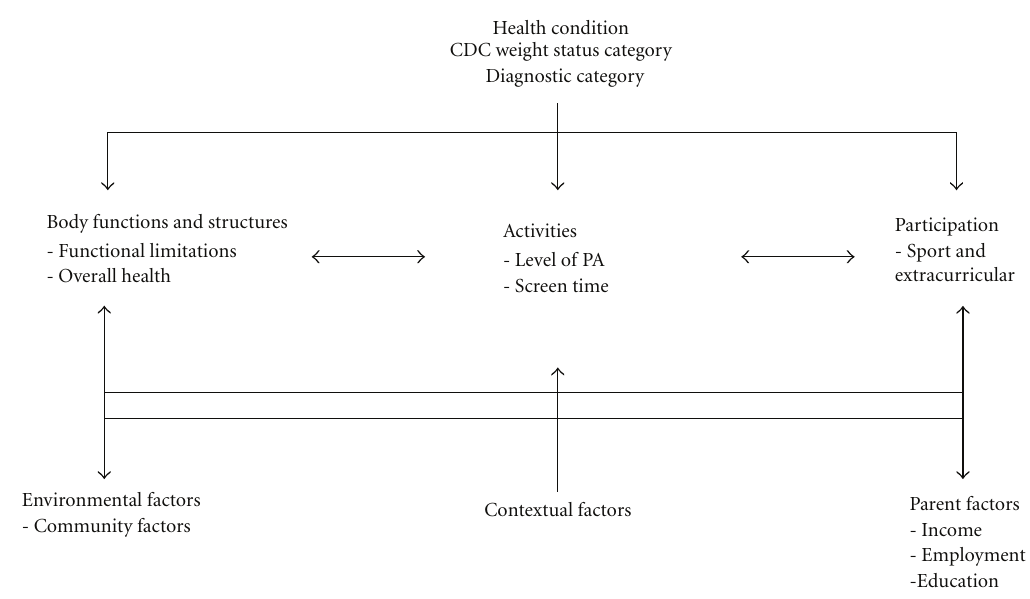
Figure 1: Modified ICF